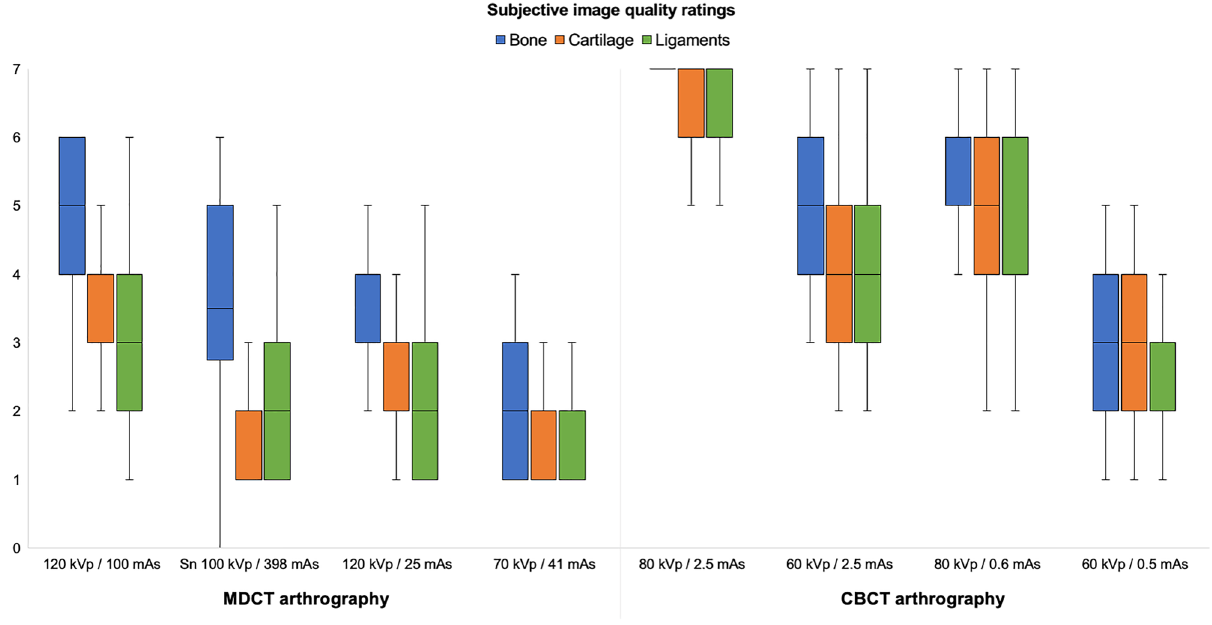
Figure 3. Box and whisker plots depict the subjective image quality ratings regarding bone, cartilage, and ligaments by seven radiologists for multidetector CT (MDCT) and cone-beam CT (CBCT) arthrography.